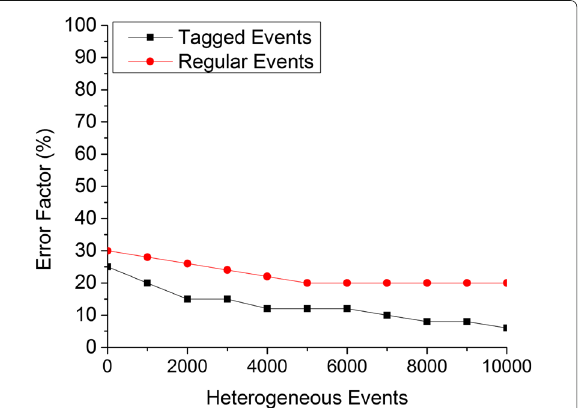
Fig. 8 Errors during Heterogeneous Event Processing